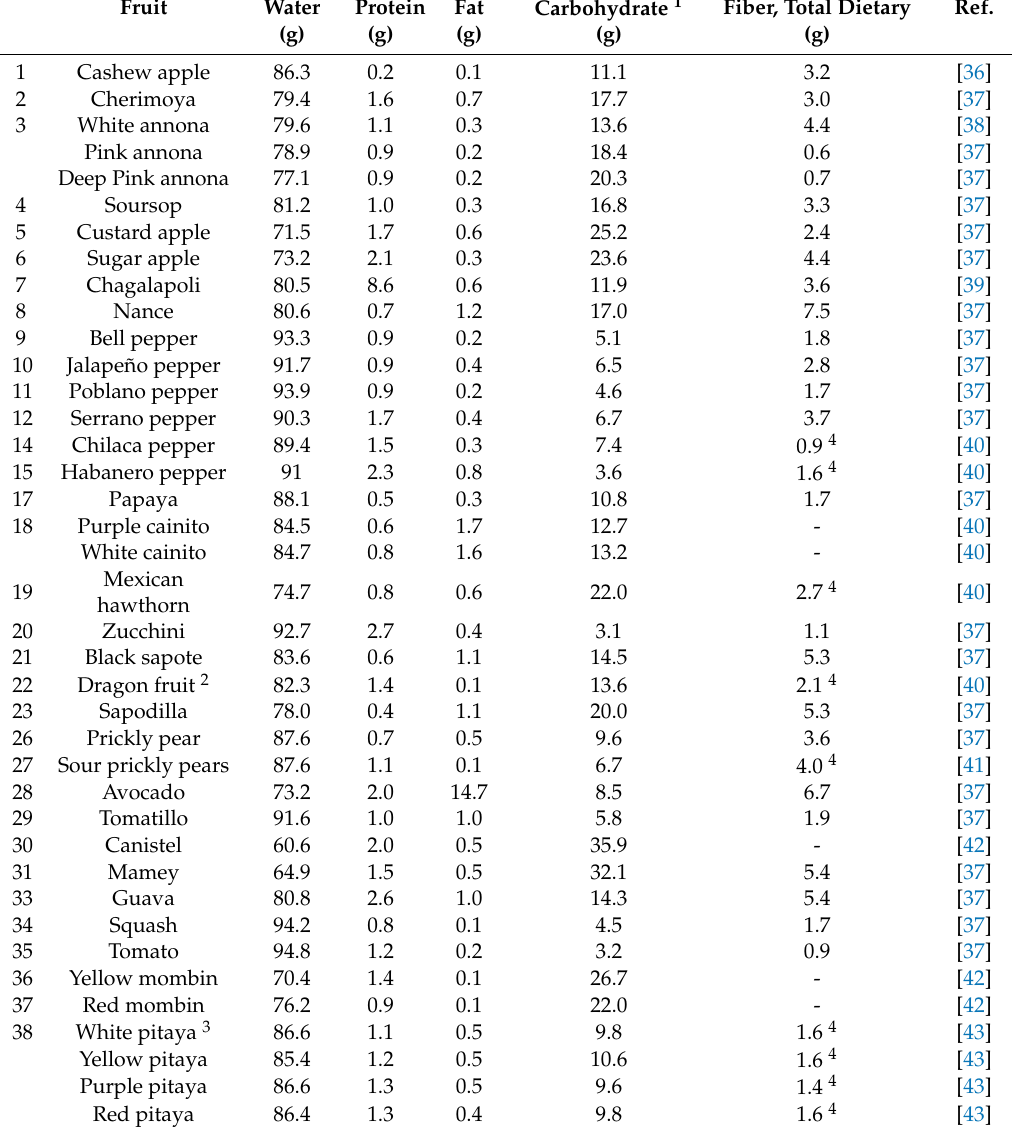
Table 2. Macronutrient composition (per 100 g) of Mesoamerican